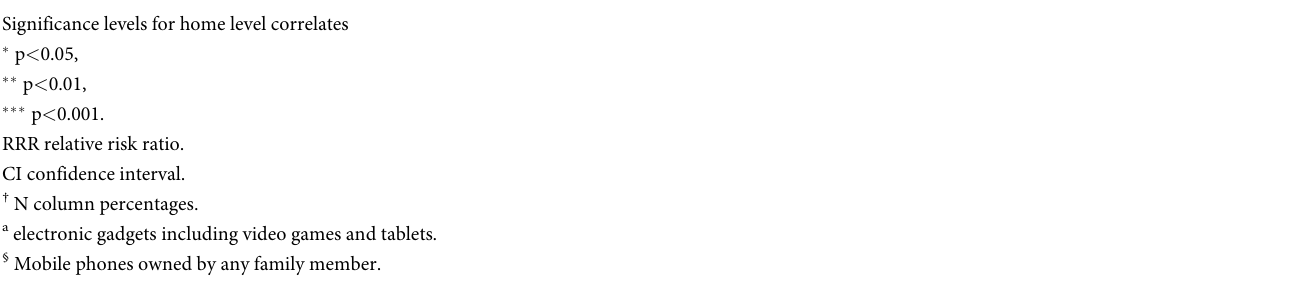
Significance levels for home level correlates